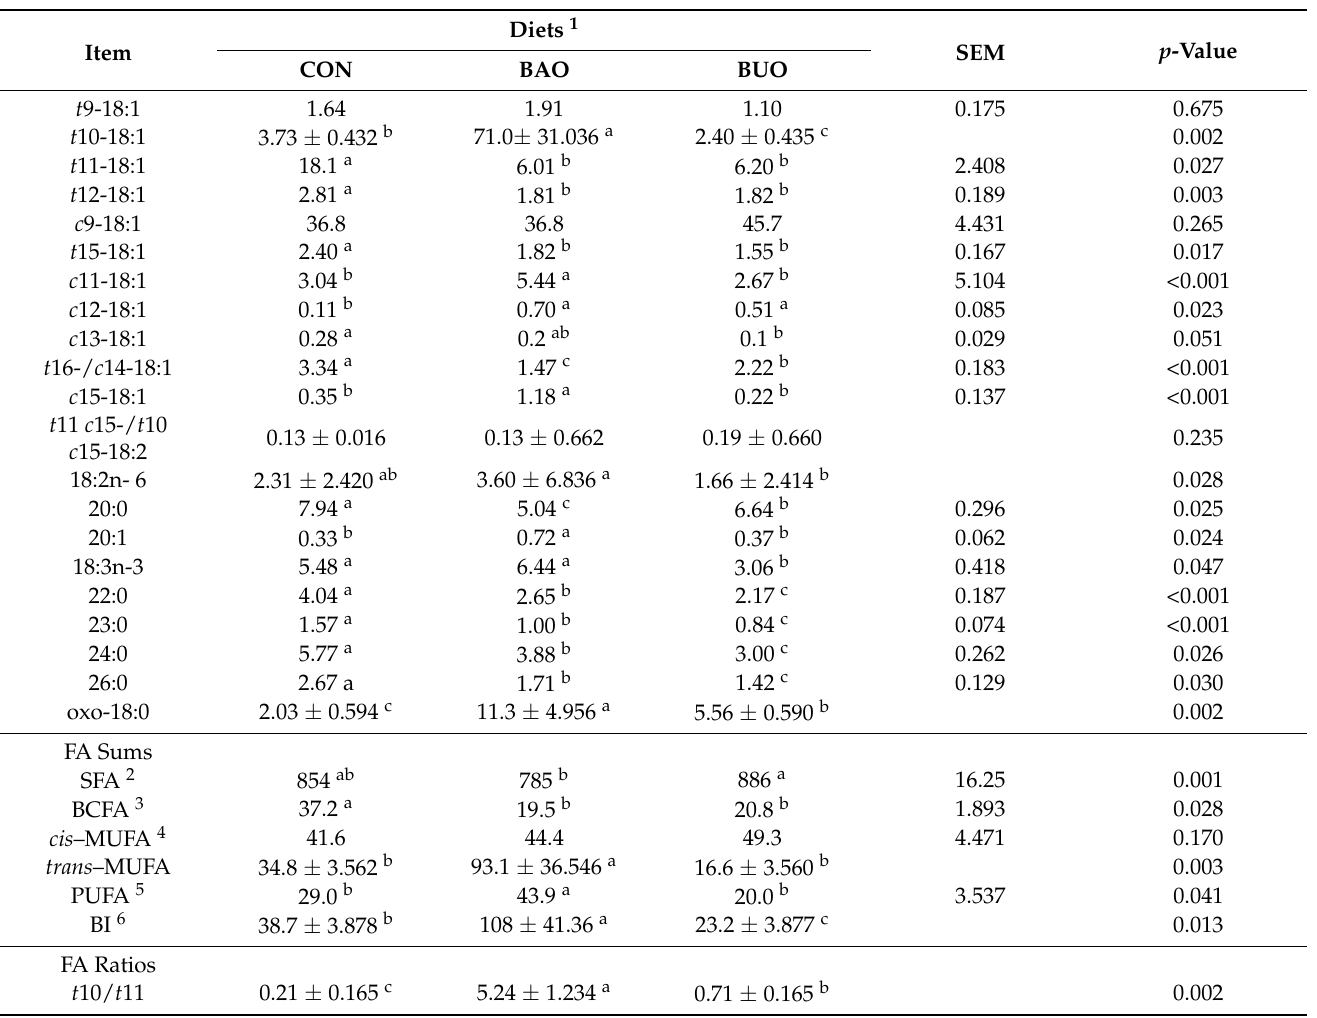
Figure 1b) and t10-18:1/t11-18:1 ratio ( p = 0.002) in relation to other diets. The t10-18:1 comprised about 66% of all biohydrogenation intermediates (BI) in BAO treatment and only ≈ 10% in the other treatments. The second most abundant BI was t11-18:1, which also differed among treatments ( p = 0.027), being higher in the CON treatment (18.1 g/kg FA) than in the supplemented diets (mean of 6.1 g/kg FA) (Table